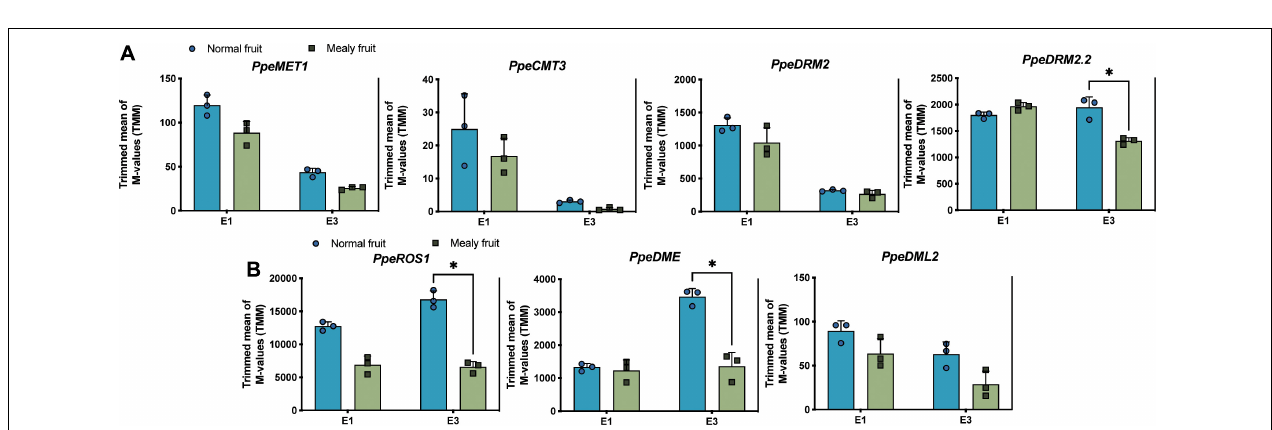
FIGURE 7 | Expression levels of four putative DNA methyltransferases and three 5-mC glycosylases in normal and mealy P.persica fruits. Transcript levels of (A) methyltransferases MET1 (Prupe.7G183100), CMT3 (Prupe.6G011600), DRM2 (Prupe.8G038800), and DRM2.2 (Prupe.6G322700). (B) Transcript levels of 5-mC glycosylases ROS1 (Prupe.7G118000), DME (Prupe.7G005000), and DML2 (Prupe.6G119100). Transcripts were analyzed by RNA-Seq using three biological replicates. Asterisks represent significant differences ( p -value ≤ 0.05) between normal and mealy fruits using a Two-Way ANOVA test. Error bars represent standard deviation